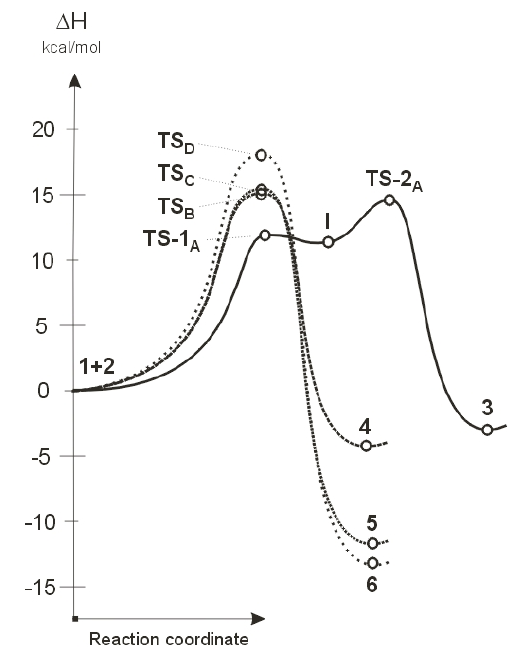
Figure 3. Enthalpy profiles for the [2+3] cycloaddition of a -phenylnitroethene 1 and (Z)-C,N-diphenylnitrone 2 in nitromethane according to B3LYP/6-31G(d) calculations (298 complex troughs are shallower and activation barriers slightly increase (Table 2). Furthermore, the asymmetry of TS complexes increases and their polarity is more distinct (Table 3).